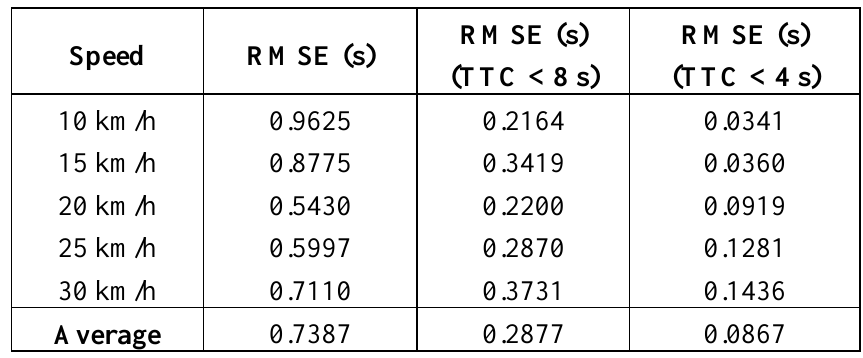
Table 1. RMSE of the